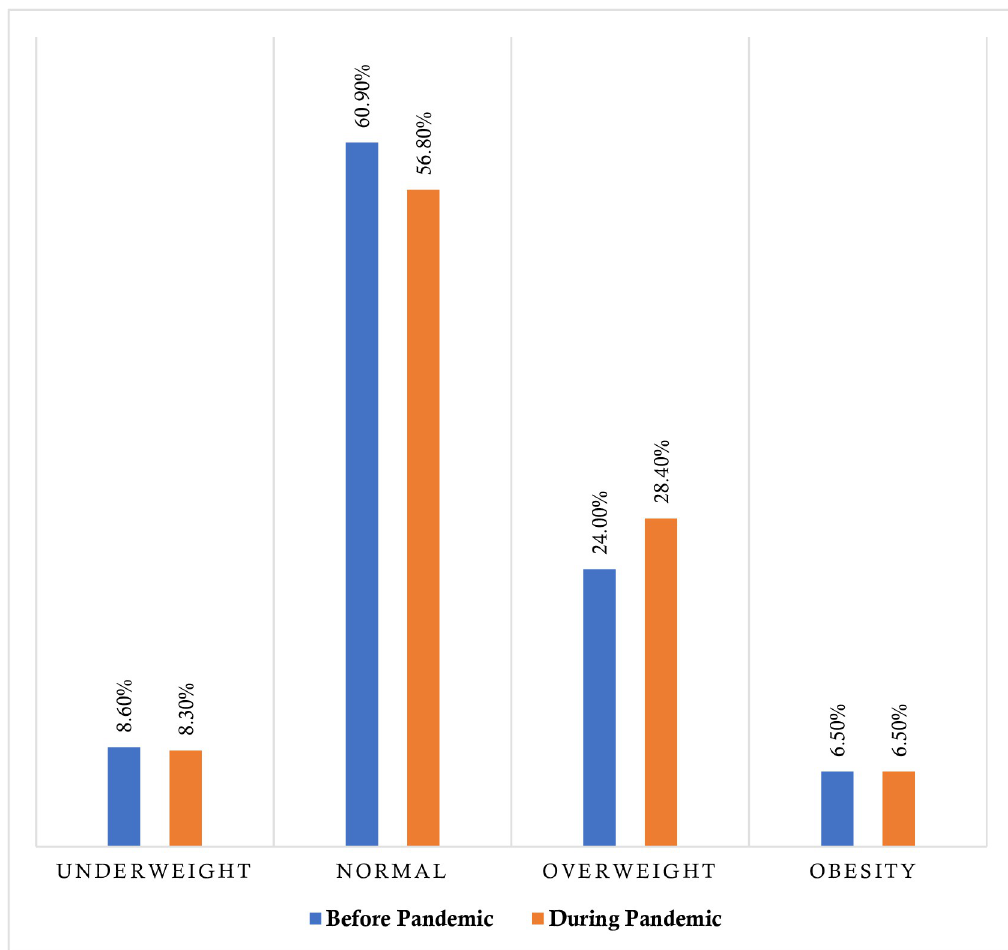
Fig 1. Prevalence of BMI status ‘before’ and ‘after’ 6-month of the pandemic inception.